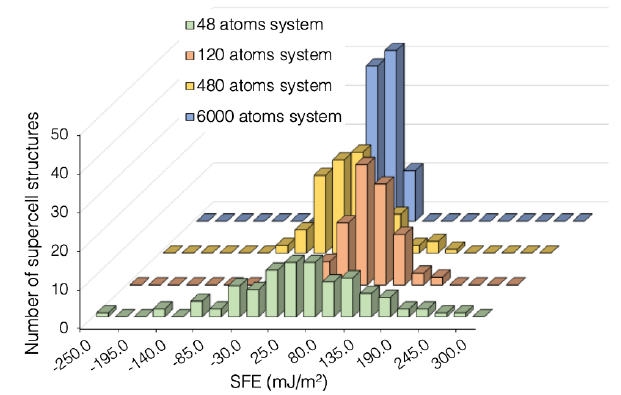
Figure 4. Effect of system size on the distribution of SFE. Four systems sizes, i.e., 48 atoms (green bar), 120 atoms (orange bar), 480 atoms (yellow bar), and 6000 atoms (blue bar) are shown. Data is collected by performing 100 simulations for each system size. As the system size increases the variation in the SFE decreases. The data is shown only for one alloy composition, i.e., Ni 50 -Fe 50 .